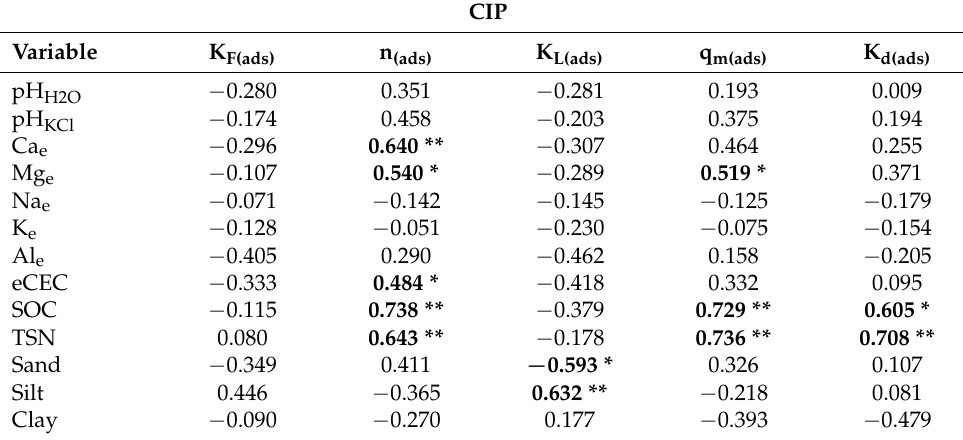
Table 7. Relations among adsorption parameters for ciprofloxacin (CIP) and trimethoprim (TRI)